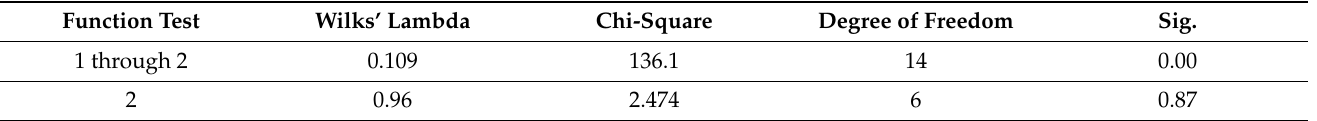
Table 11. Wilks’ Lambda results.